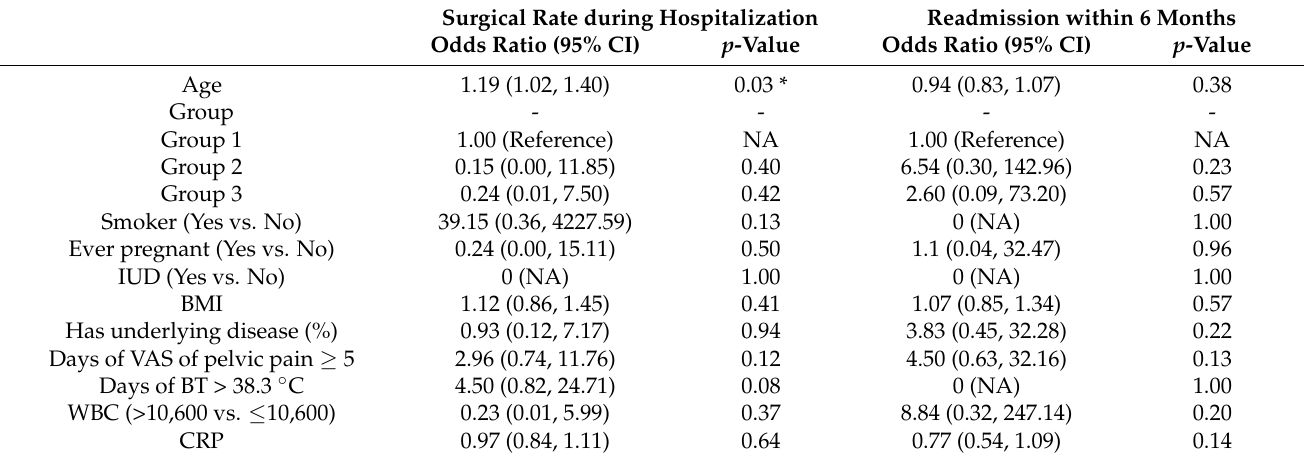
Table 2. Factors associated with primary outcomes ( n =